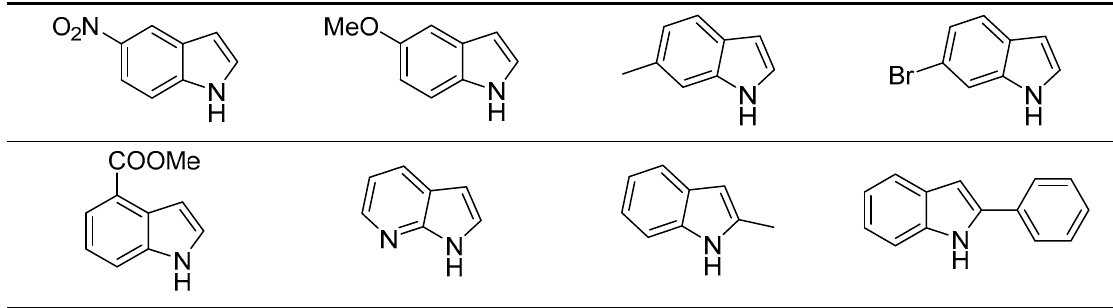
Table 2. Testing of indole derivatives.